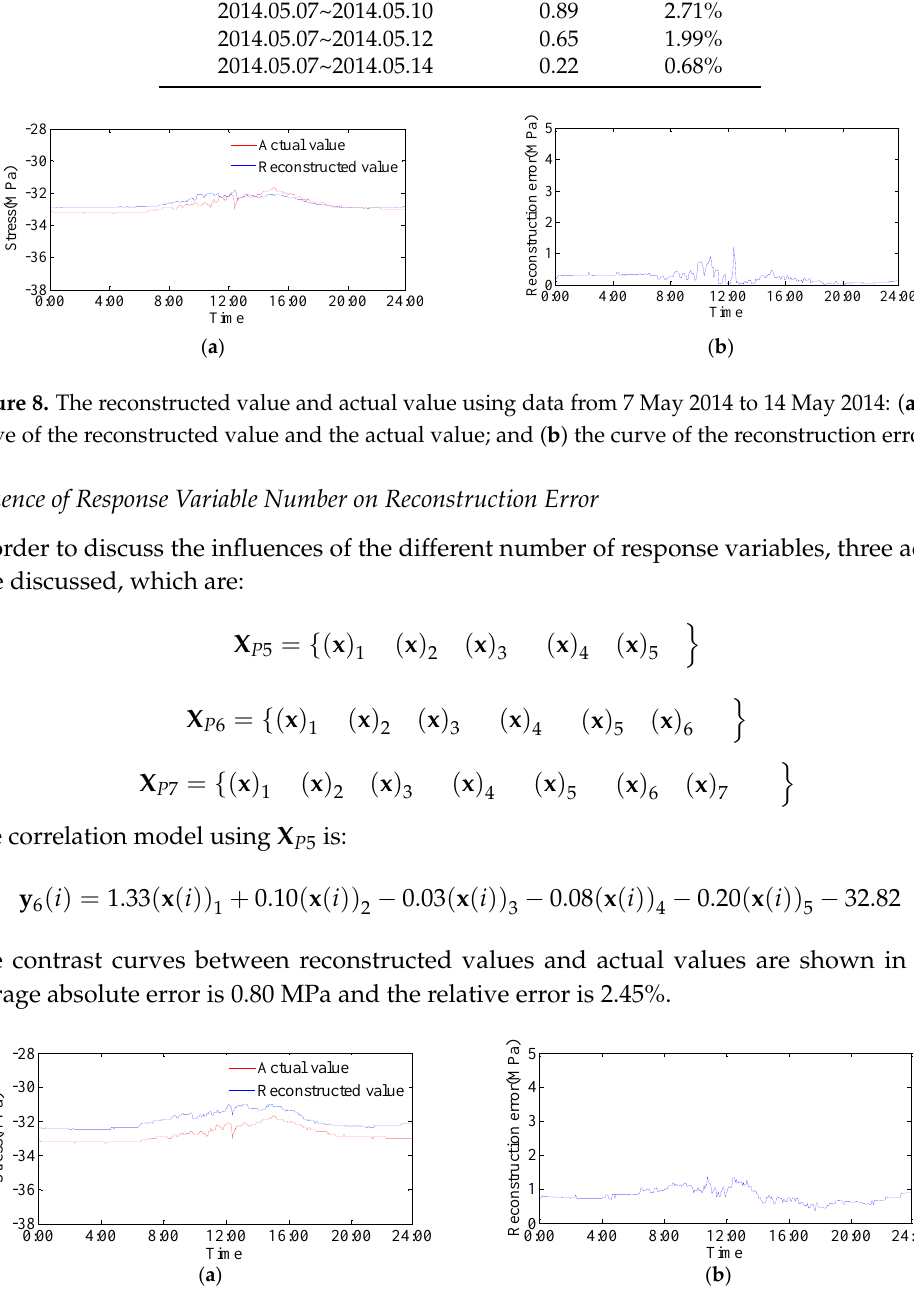
Data Acquisition Time  